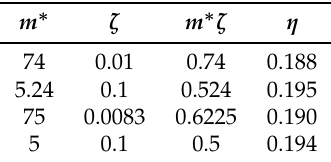
Table 2. Best efficiency points of the novel hydro-kinetic energy converter for L ∗ =